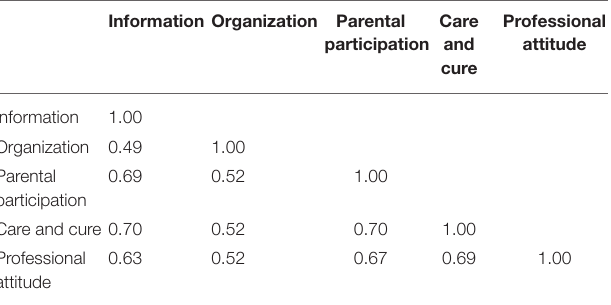
Care participation and